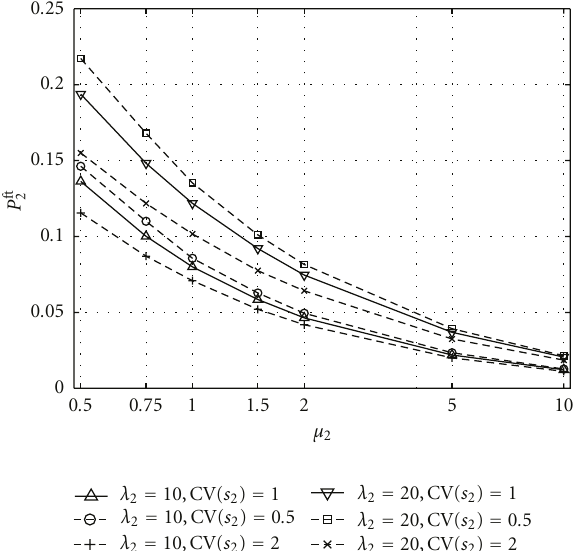
Figure 10: P ft 2 with μ 2 and CV[ s 2 ] in S5a.